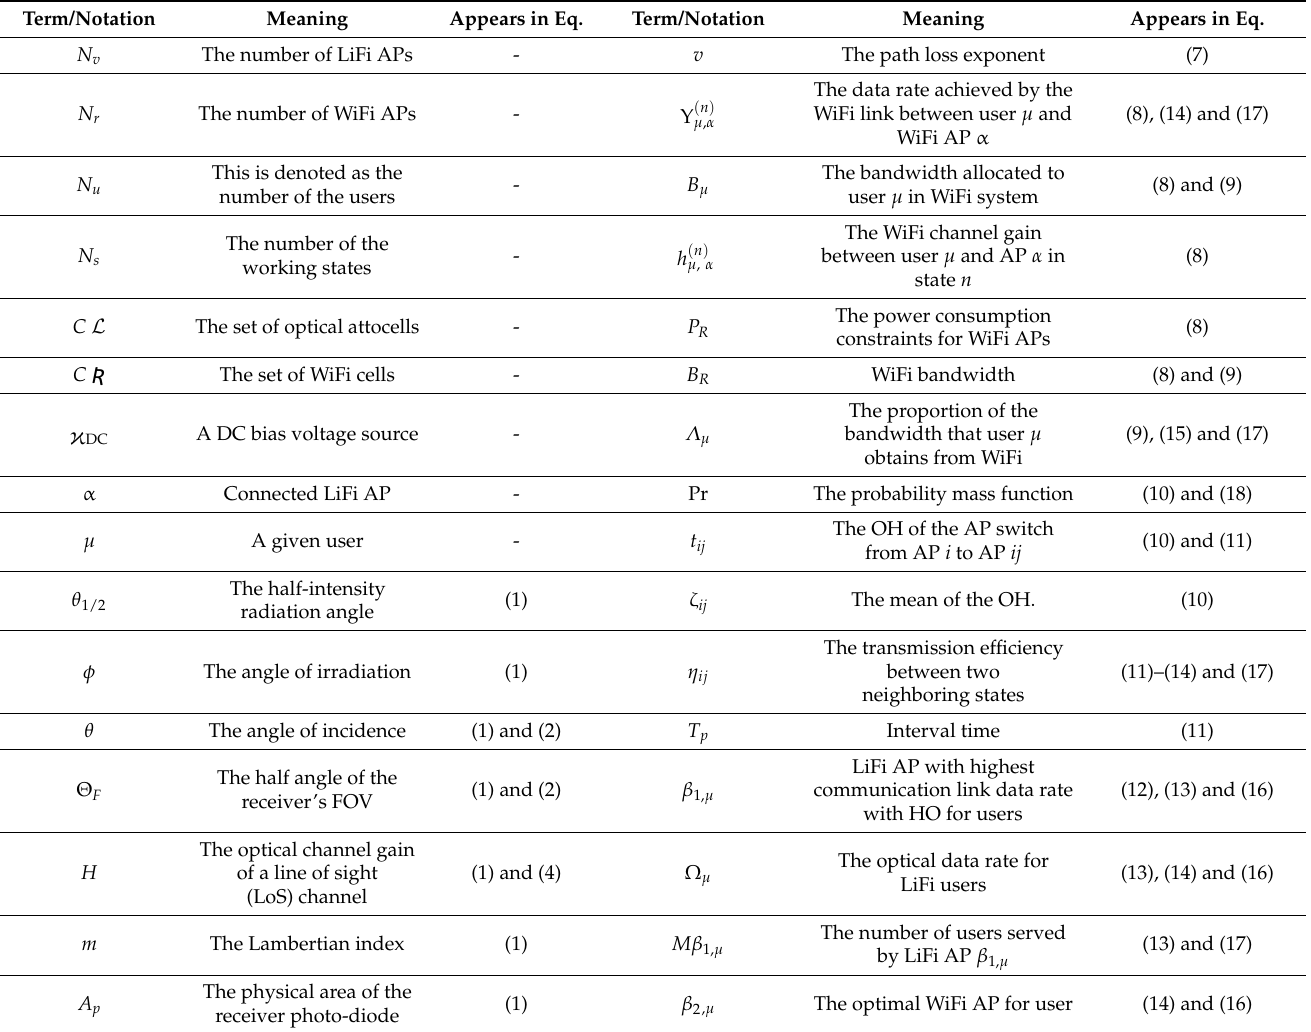
Table 3. Notations and symbols in this study.